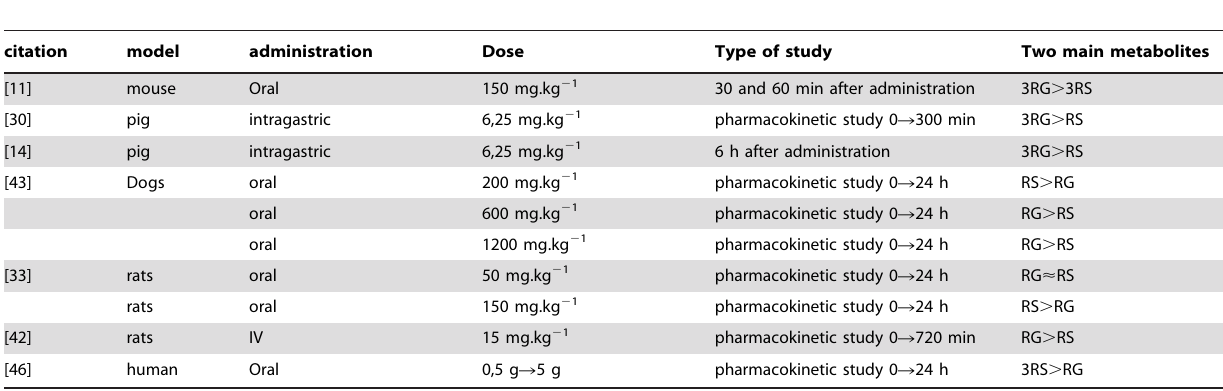
Table 3. Main resveratrol metabolites after a single dose of pure trans -resveratrol administration in different species.